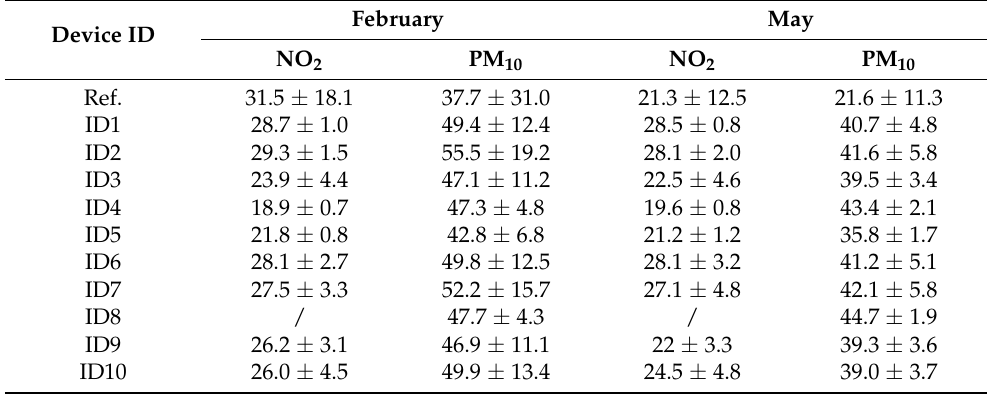
Table 1. Measurement ranges in µ g/m 3 (average ± standard deviation) for NO 2 and PM 10 . Device